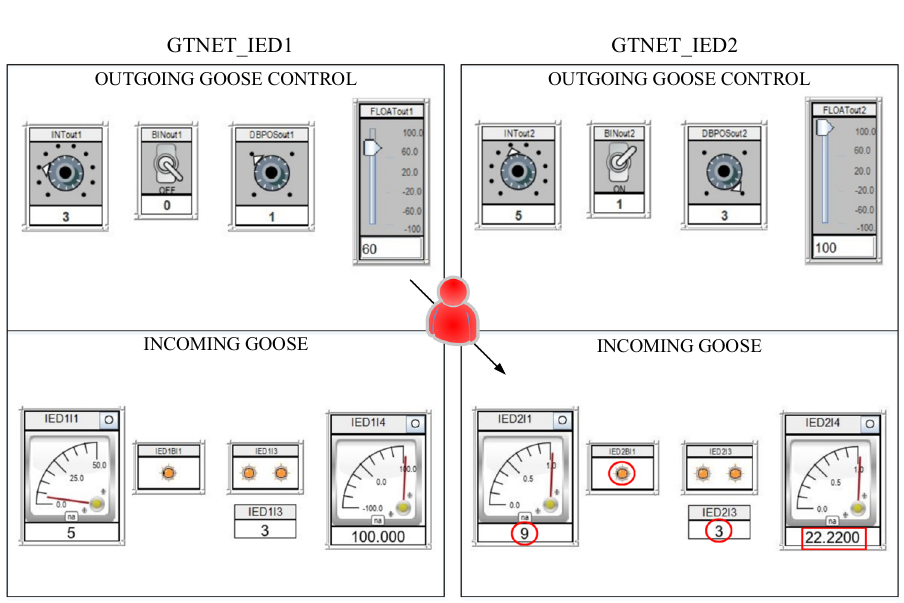
Figure 4. RTDS runtime for GOOSE communication between IED 1 and IED 2 after the manipulation of packets by the attacker 6